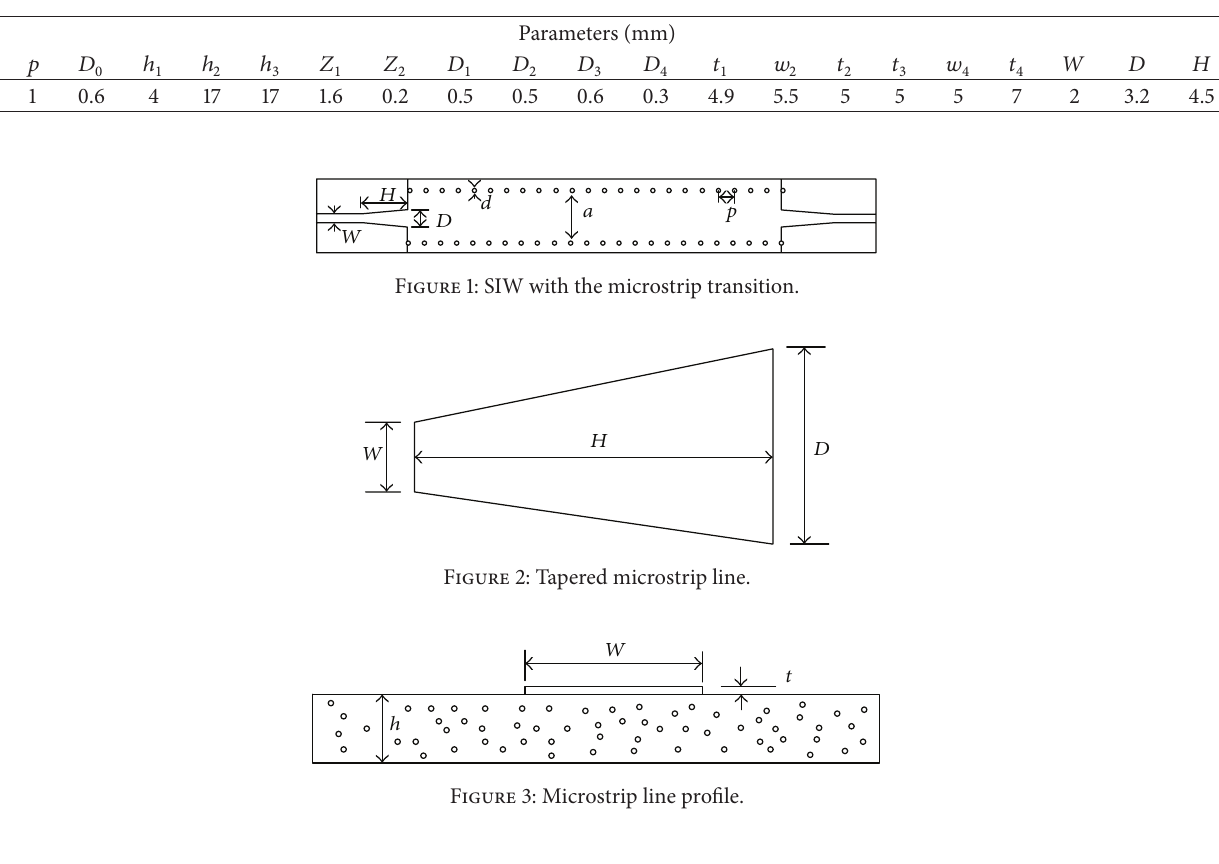
Table 1: Parameters of the 4-way SIW power divider.